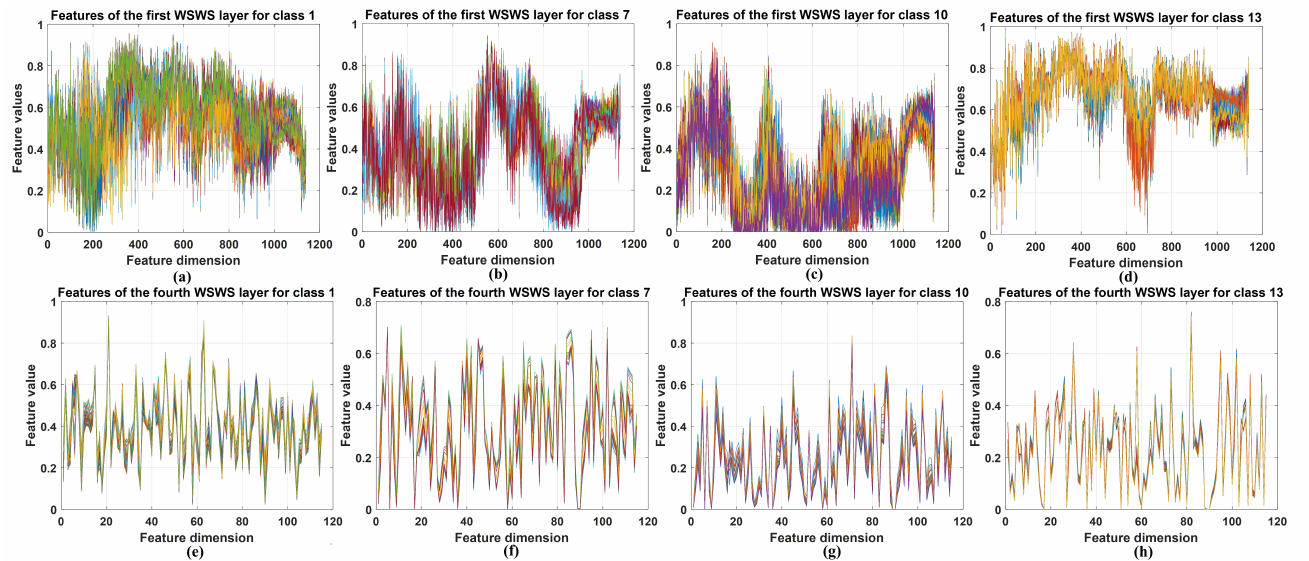
Figure 9. Visualization of the selected extracted features from the first and fourth WSWS layers of the KSC dataset. ( a – d ) The stacked results of extracted features of class 1, 7, 10, and 13 in the first WSWS layers from all the training samples. ( e – h ) The stacked results of extracted features of class 1, 7, 10, and 13 in the fourth WSWS layers from all the training samples.